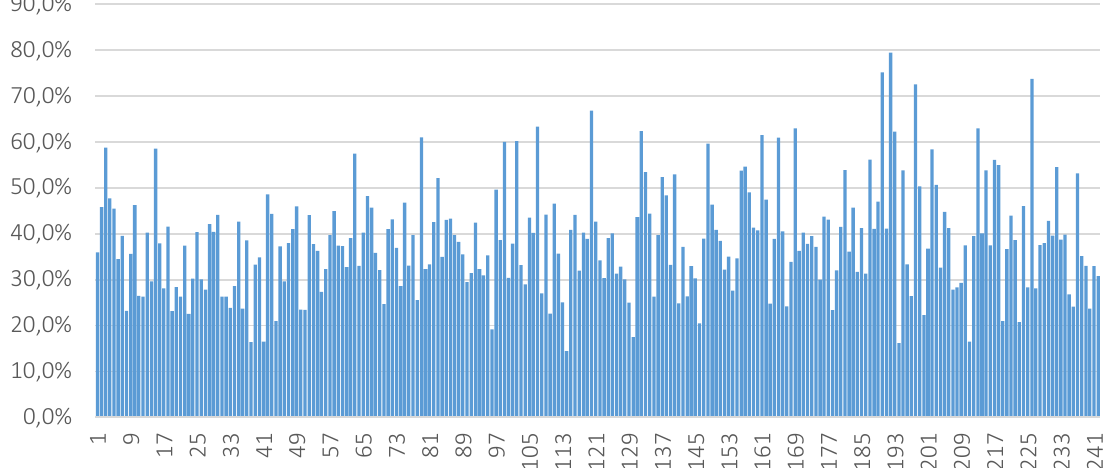
Figure 4. Percentage of samples in which distributions are not equal using Cramér-von Mises test